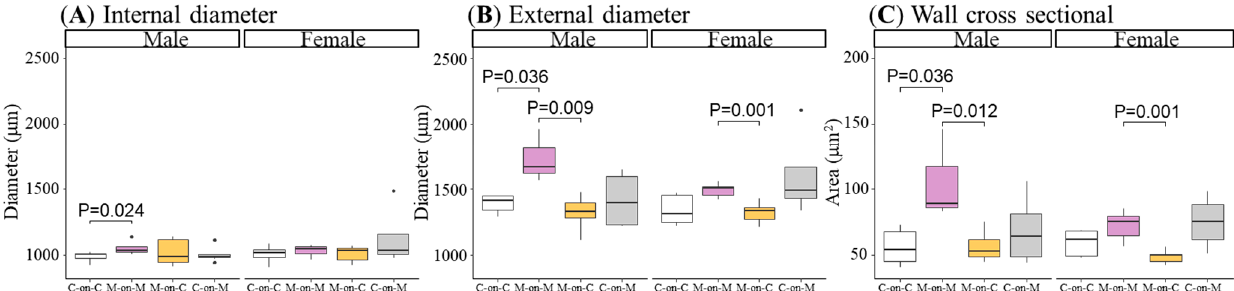
Figure 6. Internal ( A ) and external diameters ( B ), and wall cross-sectional ( C ) of the thoracic aorta